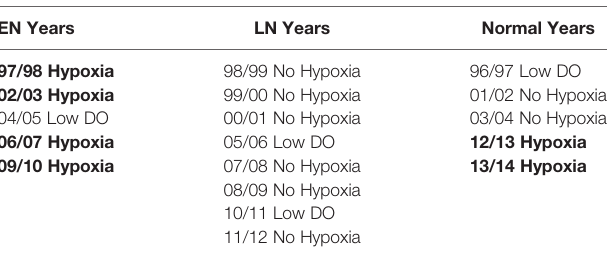
EN represents El Niño and LN means La Niña. Bold face is for hypoxia.